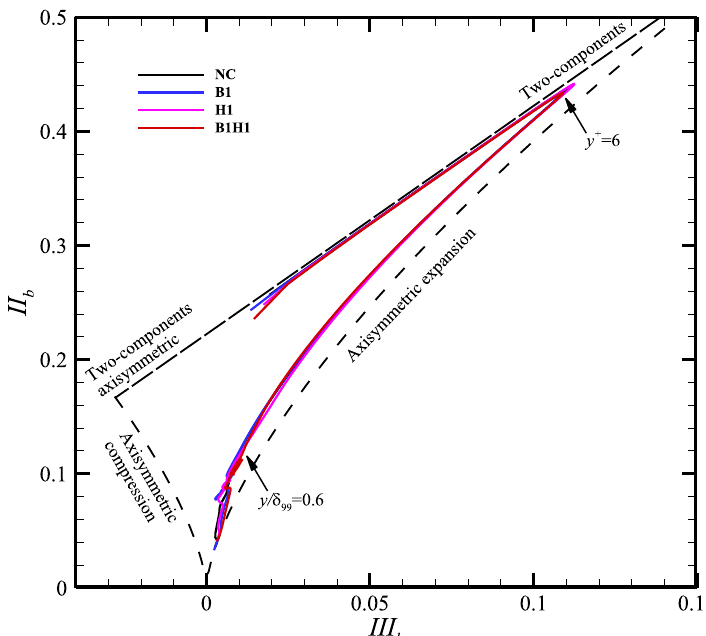
Fig. 12 Anisotropy invariant maps based on ( III b , II b ) obtained at x